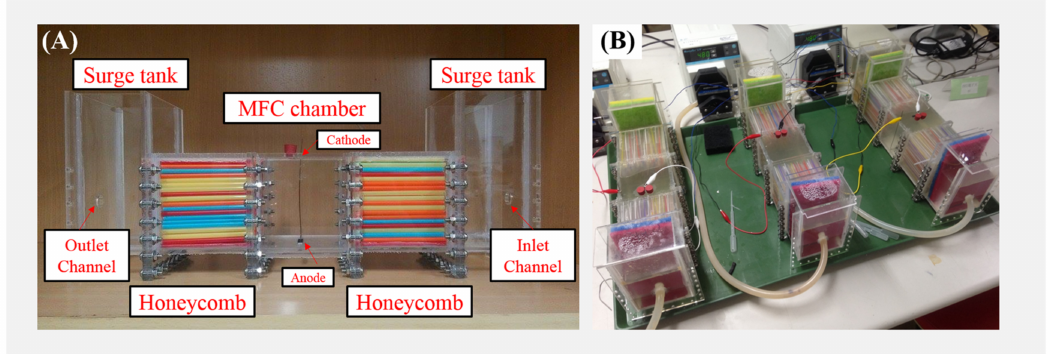
Figure 4. The ( A ) clear side view and ( B ) experimental setup of recirculation mode